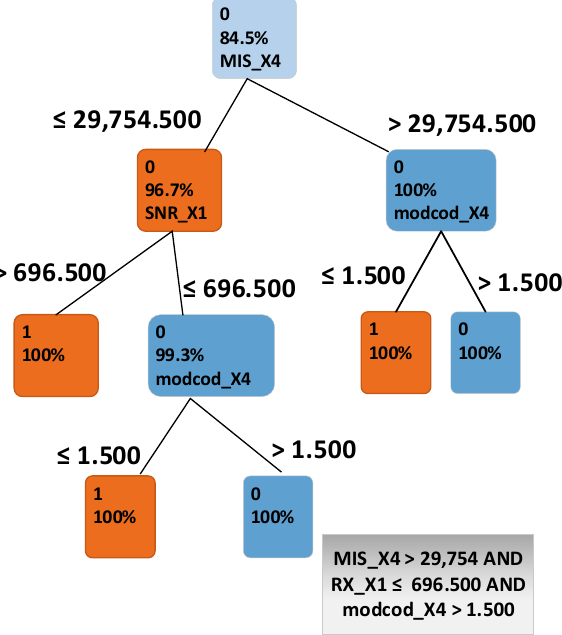
Figure 7. Classification decision tree for instances of sub route group SUB_GRP_2.